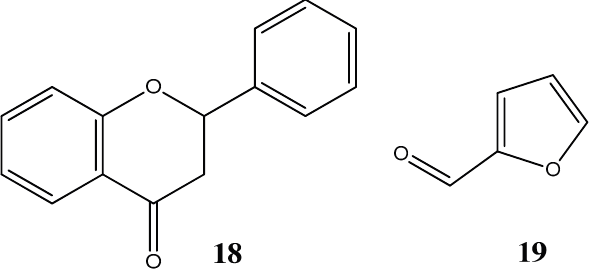
Figure 11. Chemical structure representation of flavanone core scaffold ( 18 ) and flavanone derivative, furfuraldehyde ( 19 ) with a reasonable cytotoxic activity against HT29, MCF7 and A498 cancer cell lines